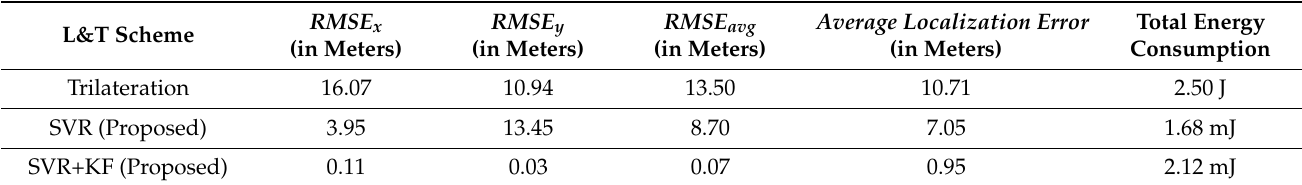
Figure 7. Case IV: impact of polynomial kernel on SVR-based target localization. ( a ) Location estimates with trilateration, SVR, and SVR+KF against the actual target trajectory, ( b ) localization error with trilateration, SVR, and SVR+KF along the x direction, ( c ) localization error with trilateration, SVR, and SVR+KF along the y direction, ( d ) localization error with trilateration, SVR, and SVR+KF along the x–y direction. Table 7. Average localization error and RMSE for case IV.